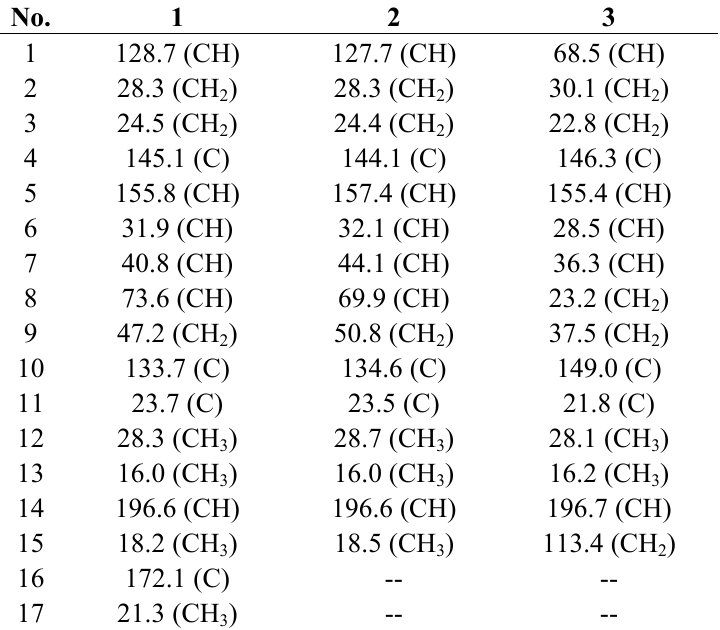
OD ( δ in ppm, recorded at 100 3